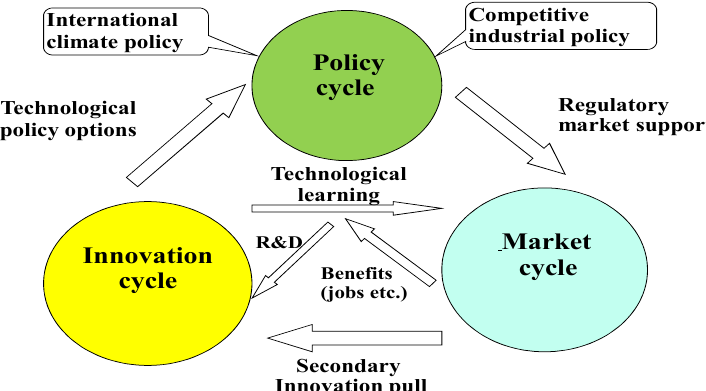
Figure 1. Mutually reinforcing cycles of clean-energy innovation